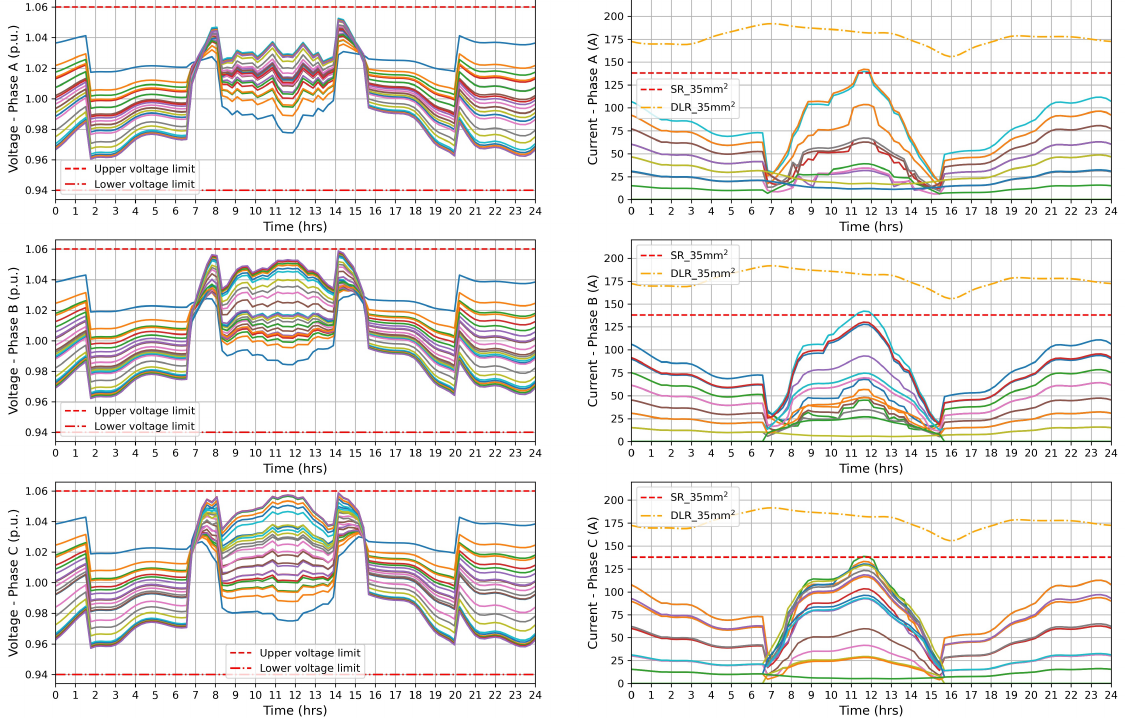
Figure 10. ( a ) Nodal voltage variation; and ( b ) branch current variation during the simulation period with SLR and OLTC voltage